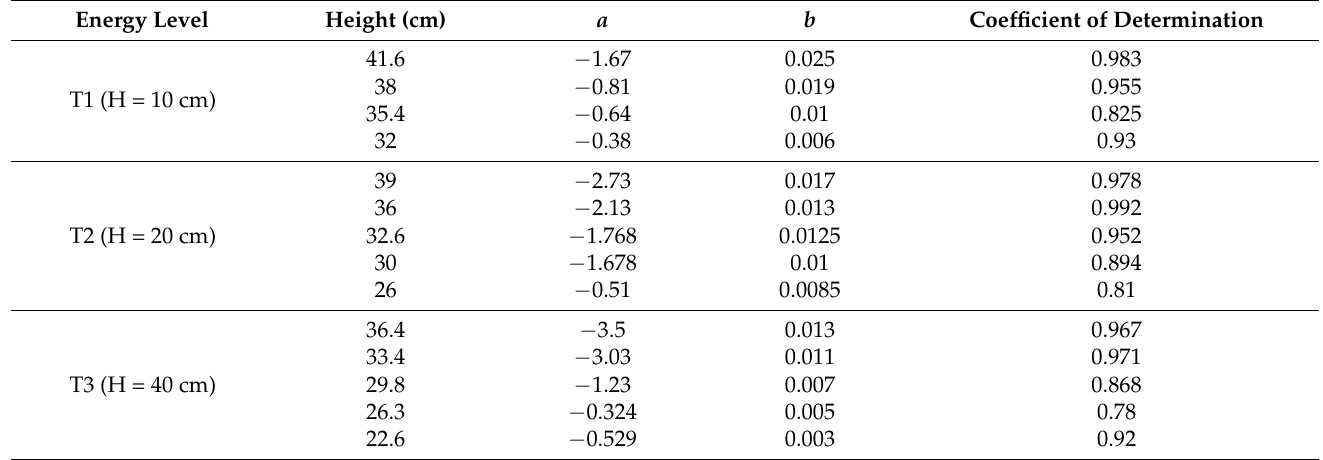
Table 2. The Gaussian fitting results for three energy